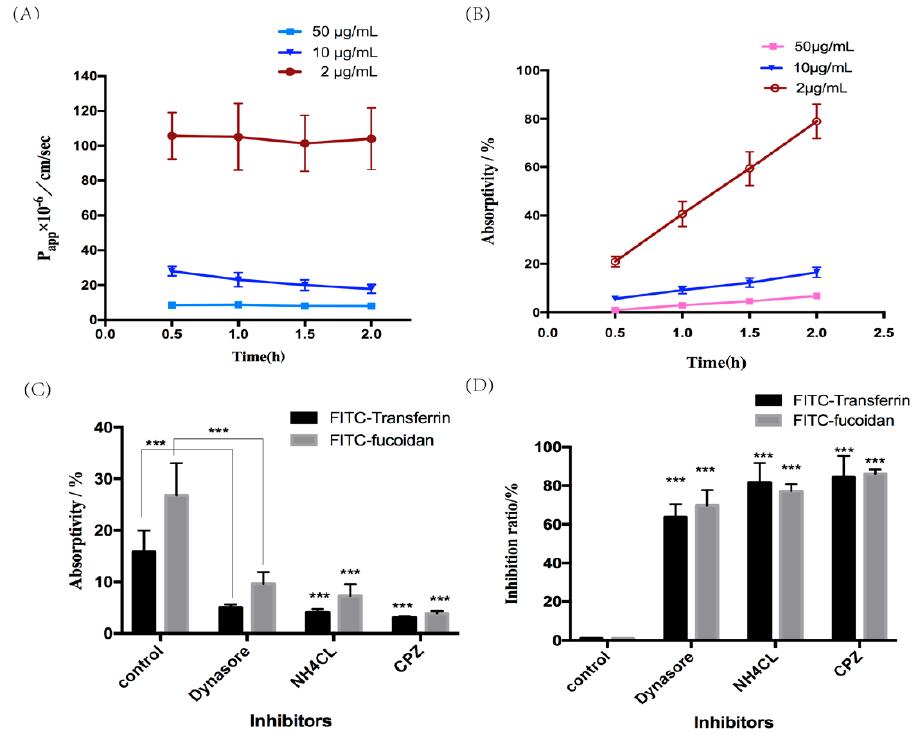
Figure 4. The absorption of FITC-fucoidan and the effect of inhibitors on it. ( A ) The Papp of FITC-fucoidan at different time and concentration was expressed as the means ± SD ( n = 3). ( B ) The absorptivity of FITC-fucoidan at different time and concentration was expressed as the means ± SD ( n = 3). ( C ) The absorptivity of FITC-transferrin and FITC-fucoidan by adding clathrin inhibitors CPZ, Dynasore and NH 4 CL was expressed as the means ± SD ( n = 3). ( D ) The inhibition rate of FITC-Transferrin and FITC-fucoidan by adding clathrin inhibitors CPZ, Dynasore and NH 4 CL was expressed as the means ± SD ( n = 3).